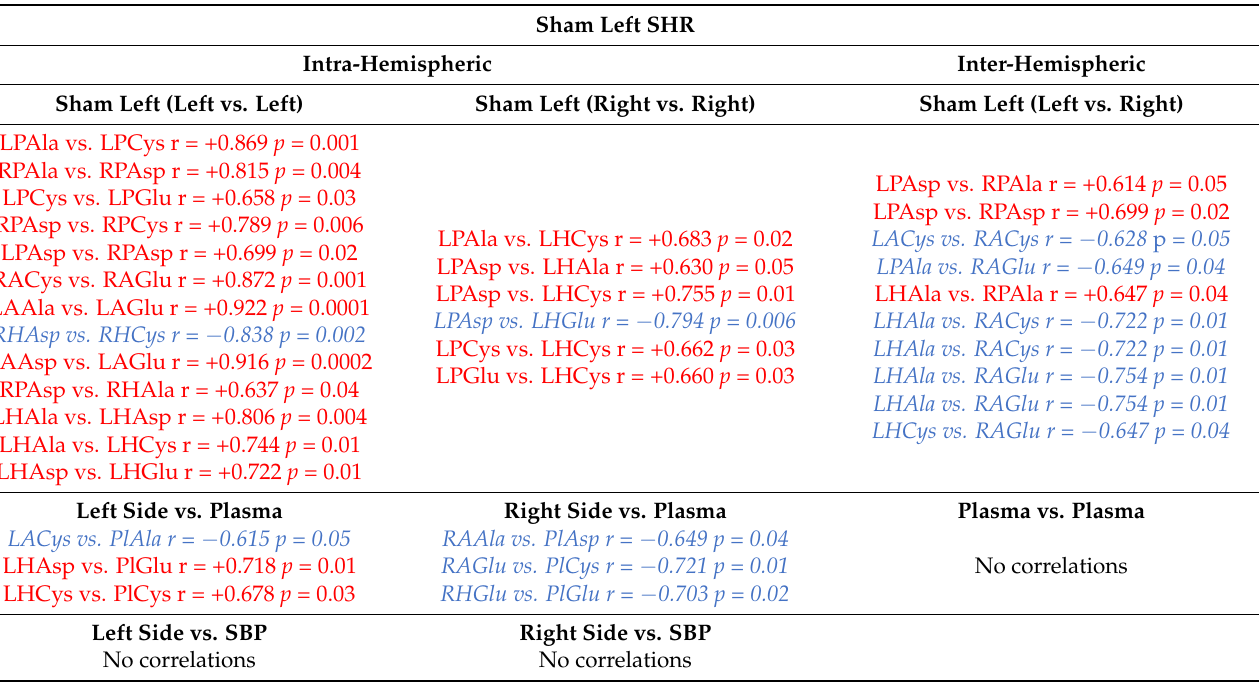
Table 1. Intra- and inter-hemispheric correlations between brain aminopeptidase activities; between plasma aminopeptidase activities; between plasma aminopeptidase activities versus brain aminopep- tidase activities and between aminopeptidase activities versus systolic blood pressure (SBP) in sham left spontaneously hypertensive rats (SHR). Sham Left SHR Intra-Hemispheric Inter-Hemispheric Sham Left (Left vs. Left) Sham Left (Right vs. Right) Sham Left (Left vs. Right)